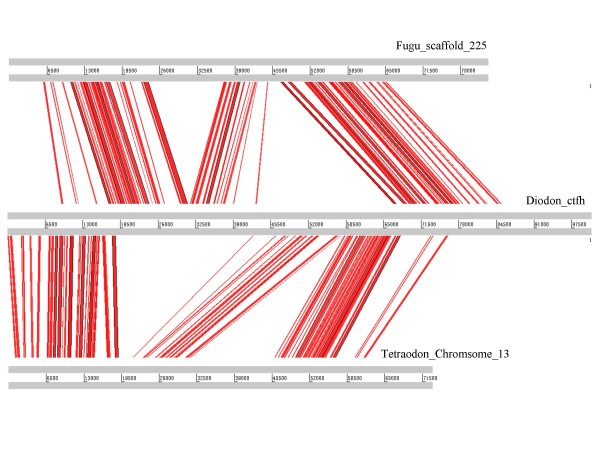
Microsynteny between the sequences of clone ctfh in D. holocanthus genome and its homologous region in T. rubripes and Te. nigroviridis genome. The length of the bar represents the relatively length of the sequence, and the lines between the bars represent the high-scoring segment pair (HSP) of the BLASTN searches between the sequences. Other microsyntenic relationships between the BAC clone sequences of D. holocanthus and the smooth pufferfish genomes were given in additional file 1.